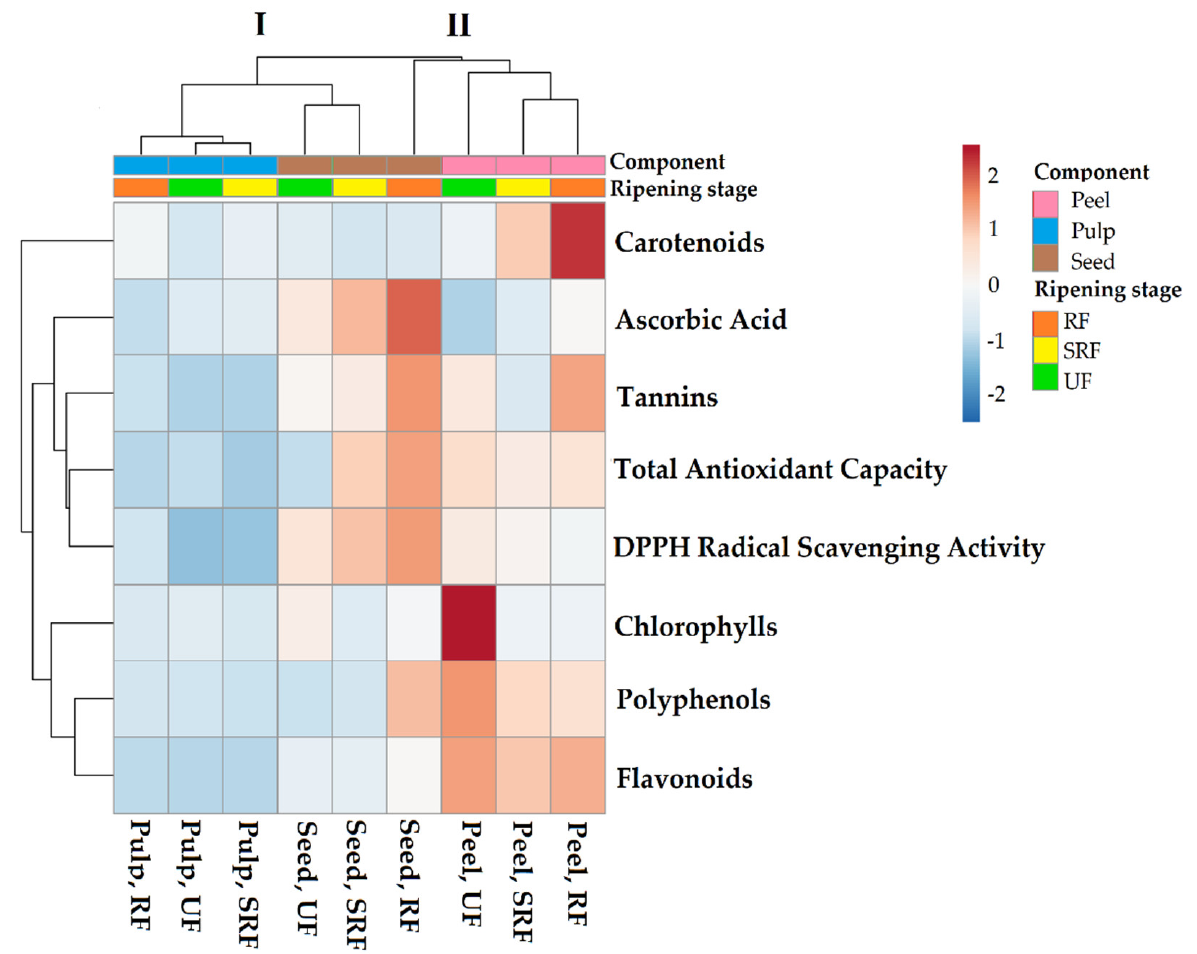
Figure 5. Heatmap analysis of bioactive compounds in different fruit components (peel, pulp, and seed) of Phlegrean mandarin at different ripening stages (UF—unripe fruit, SRF—semi-ripe fruit, and RF—ripe fruits). Numeric differences within the data matrix are shown by the sequential color palette: blue and red indicate decreasing and increasing values, respectively. Sample groups are clustered in the columns by the two independent factors, Component and Ripening Stage.